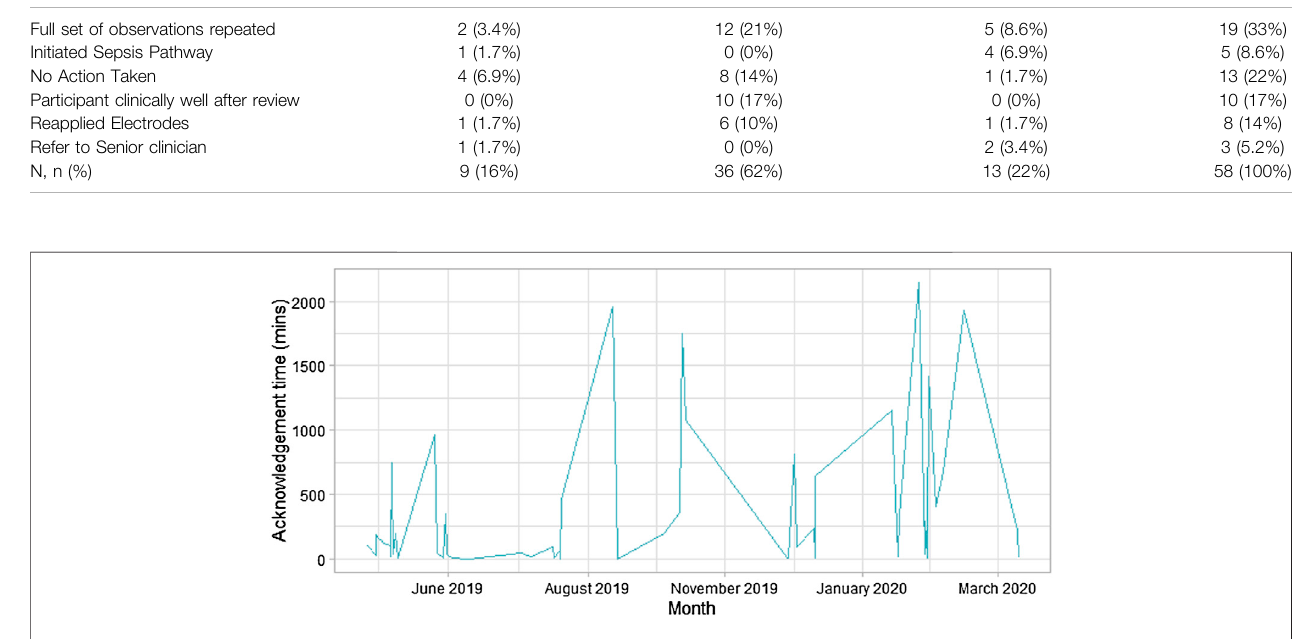
TABLE 2 | Action taken following abnormal vital sign (heart rate, respiratory rate, temperature) alert. Action Taken Heart Rate Respiratory Rate Temperature N